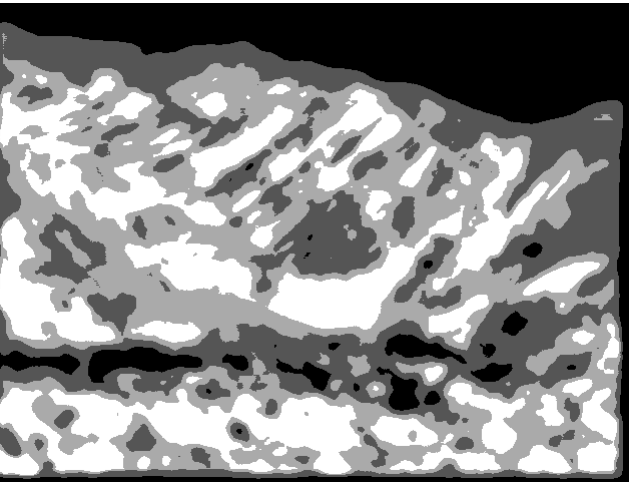
Figure 7. Output of the proposed image analysis procedure where four scales have been properly combined in the spatial regularization step, before applying histogram equalization. A more detailed segmentation is provided in this